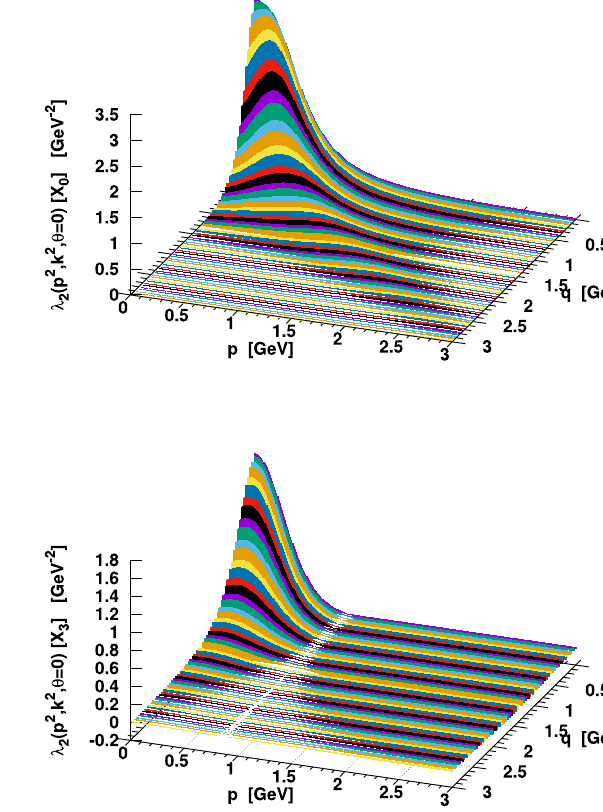
Fig. 6 The contribution proportional to X 0 (left) and to Y 1 to the form factor λ 1